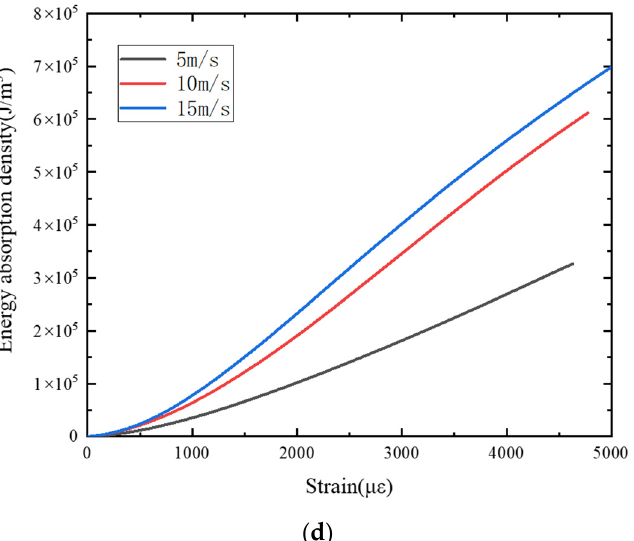
Figure 10. Energy absorption density–strain curve. ( a ) Impact velocity of 5 m/s. ( b ) Impact velocity of 10 m/s. ( c ) Impact velocity of 15 m/s. ( d ) Average value.